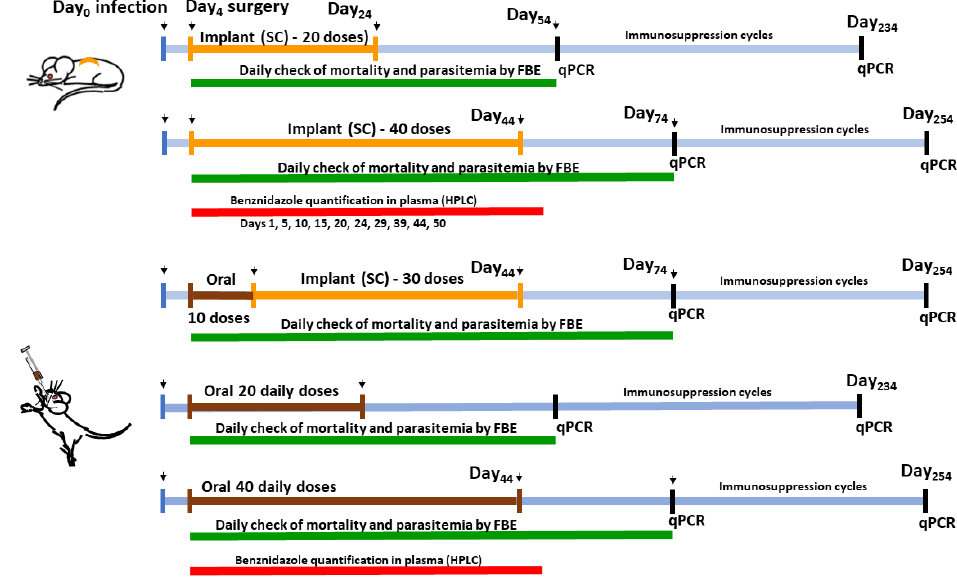
Figure 1. Experimental design of in vivo experiments of efficacy and determination of benznidazole plasma concentration – time profiles during treatment with the different benznidazole formulations (oral doses and subcutaneous implants).